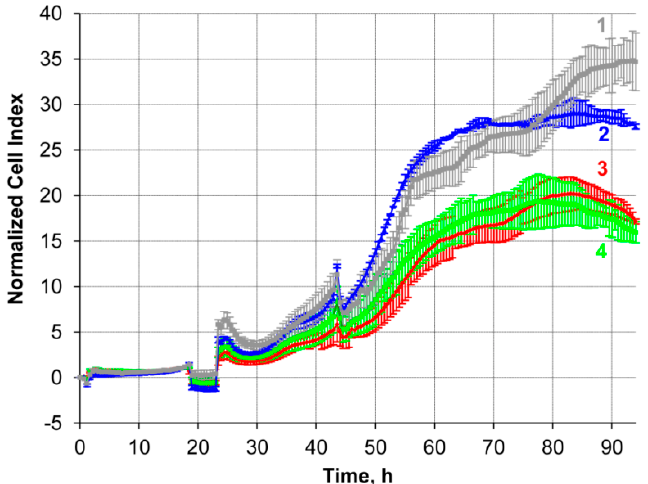
Figure 12. Restoration of sensitivity of KB-8-5 cells to vinblastine. The cell index of living KB-8-5 cells was estimated in real-time mode with an xCELLigence instrument. Cells were treated with 6 µM TD3/MDR1-ON or TD3/MDR1gap-ON duplexes for 24 h followed by addition incubation of cells in the presence of 300 nM vinblastine for 72 h. (1) control, intact cells; cells treated with (2) TD3/Scramble, (3) TD3/MDR1-ON, or (4) TD3/MDR1gap-ON duplexes (6 µM).